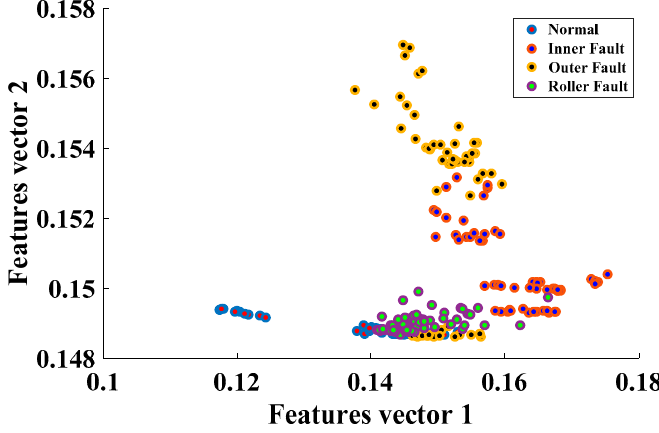
Figure 8. The extracted high-level features for the fault pattern recognition layer.